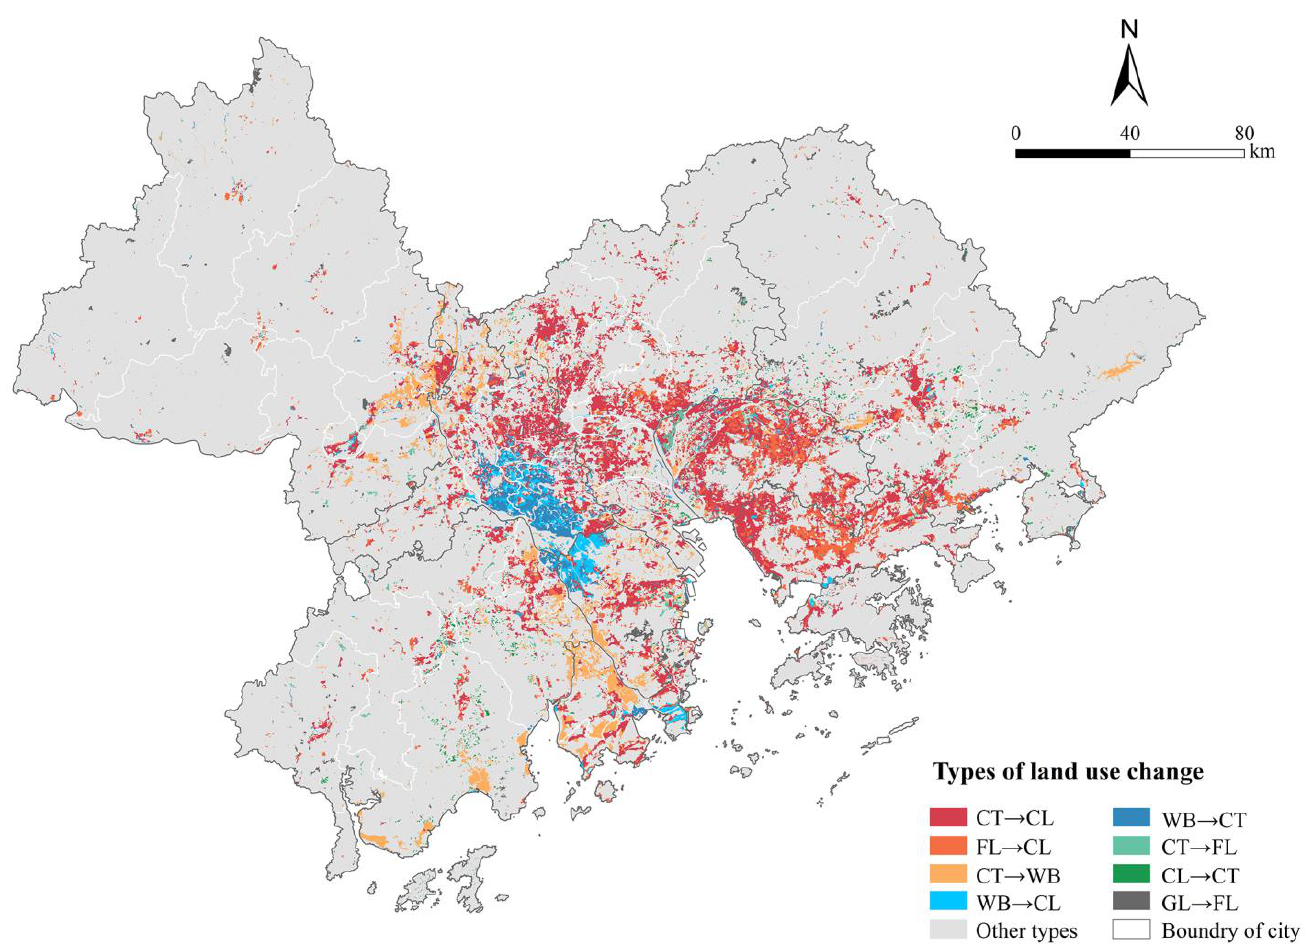
Figure 7. Spatial distribution of major conversions of land use types from 1980 to 2020 in the GBA. The Sankey diagram below clearly reflects the main direction and scale of land use conversion over the years (Figure 8). Notably, over the past 40 years, the increase in construction land mainly came from the occupation of cultivated land, forestland, and grassland. The expansion mainly occurred in coastal cities and their main districts such as Dongguan, Shenzhen, the Yuexiu District of Guangzhou, the Chancheng District of Foshan, etc. At the same time, there were also conversions among cultivated land, water bodies, and forestland, due to adjustments of the agricultural structure and the implementation of a farming compensation policy.